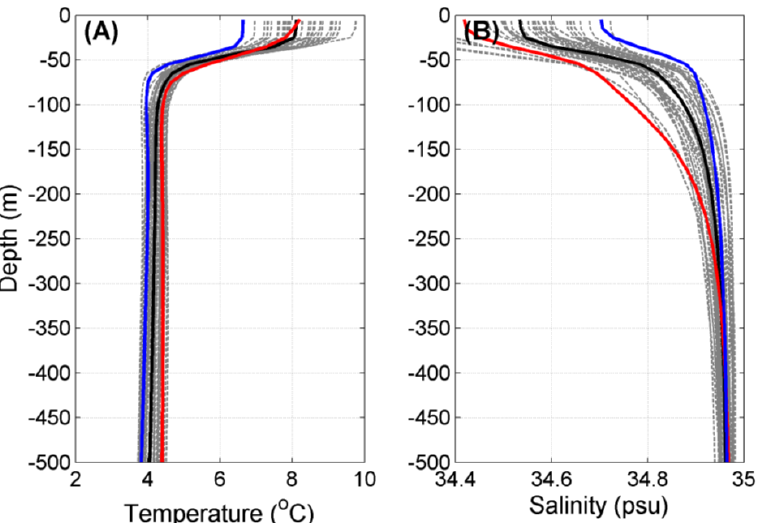
Figure 3. Simulated profiles of temperature ( A ) and salinity ( B ) in September of 2009 (red), 2016 (blue) and climatic September (black) averaged over 1979–2016 within the 2000 m isobaths in CTRL. The simulated profiles of temperature and salinity in other years (grey dotted lines) are also given.